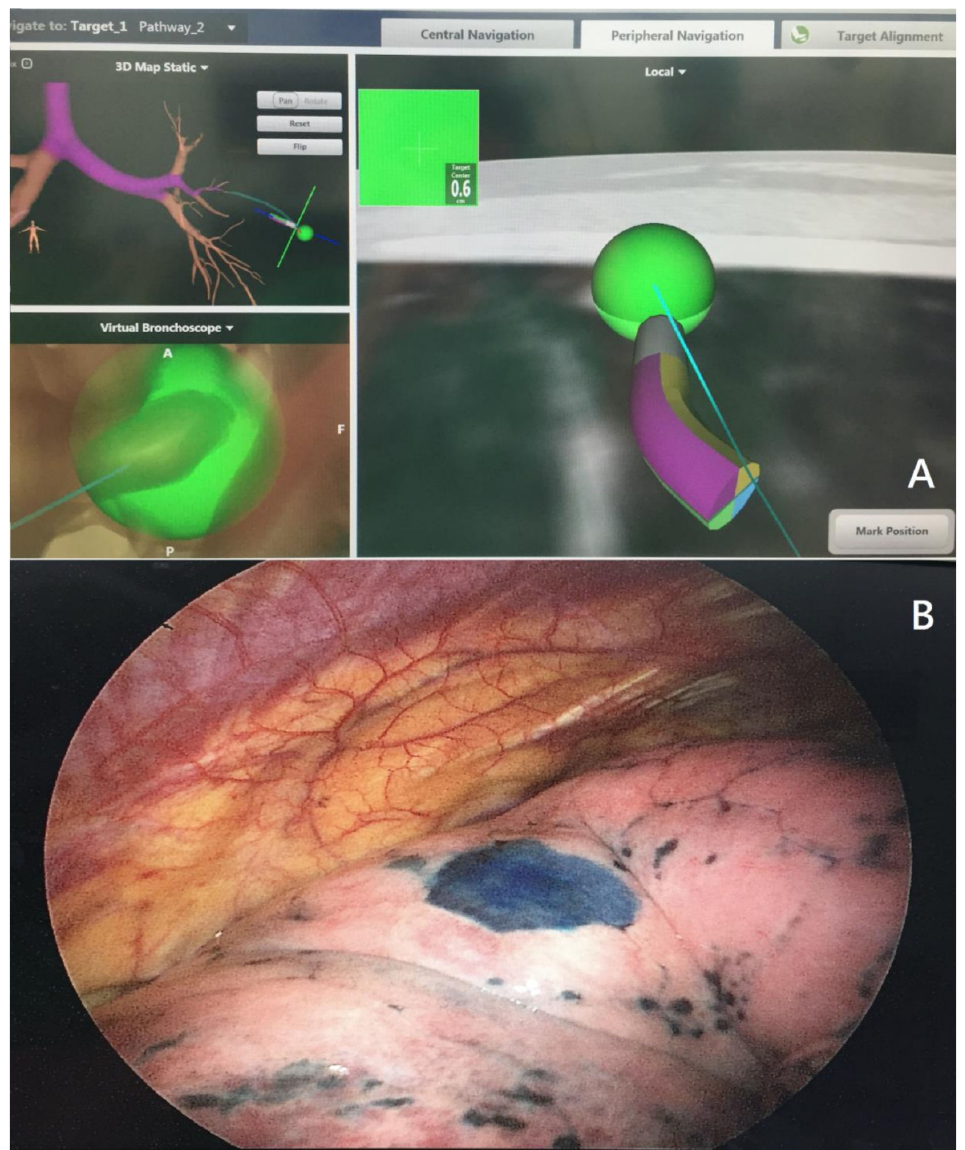
Figure 1. ( A ) ENB navigation for localization of the lung nodule; ( B ) ENB localization shows the lung tumor position by pleural marking during